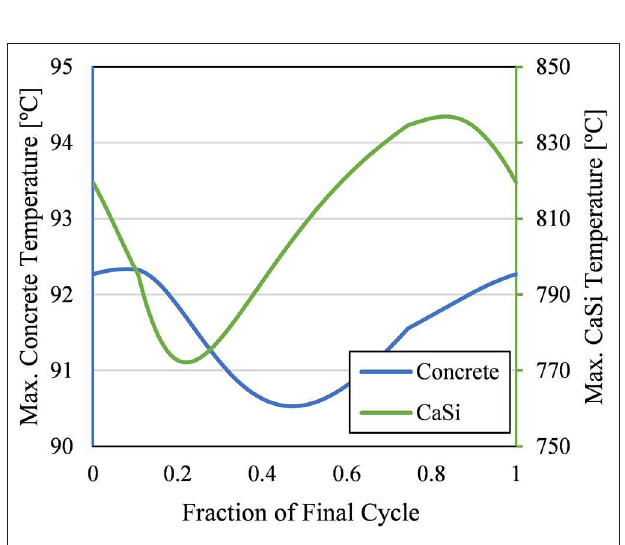
FIGURE 10 | Maximum temperatures of concrete (left) and CaSi (right) throughout the final cycle. The thermal limits of concrete and CaSi are 100 and 1,000 ◦ C